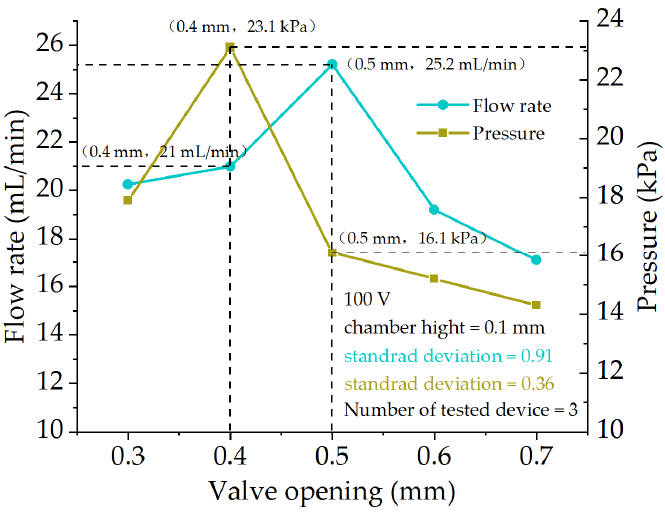
Figure 6. Output performance of different valve opening.